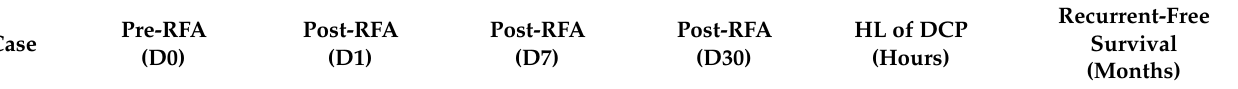
Table 3. Series of DCP values of 11 patients with discordant results between HLs of DCP and RFA